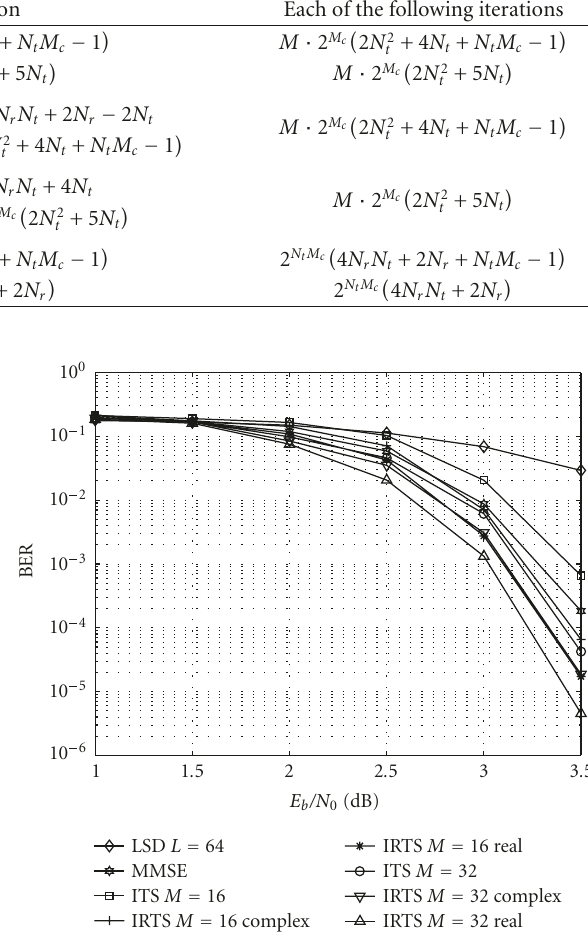
Figure 2: Bit error performance of the 4 × 4 ST-BICM MIMO sys- tem. Figure 3: Bit error performance of the 8 × 8 ST-BICM MIMO sys-